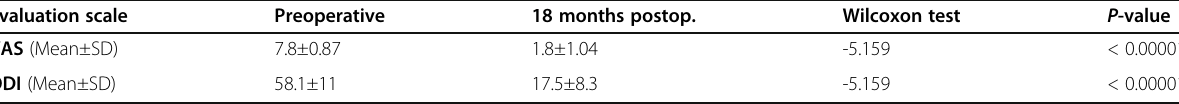
Table 7 Preoperative and 18 months postoperative VAS and ODI Evaluation